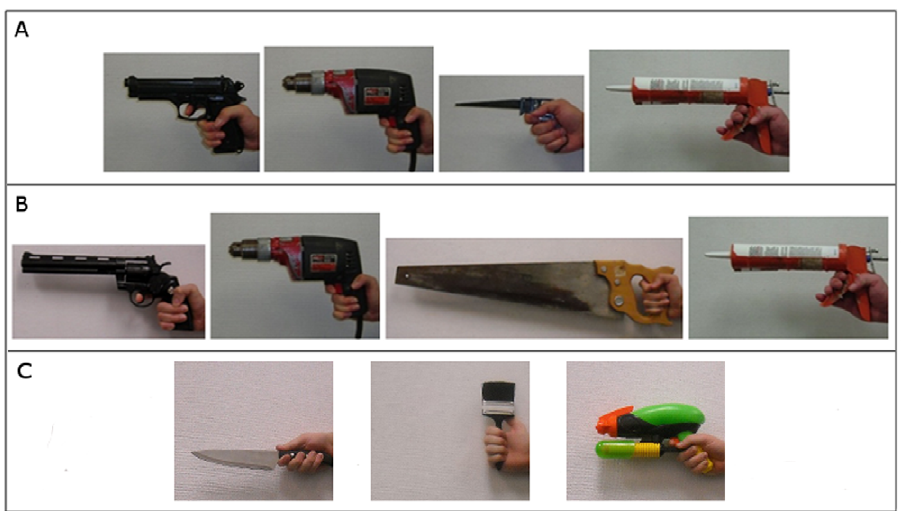
Figure 2. Stimuli. Panel A: In Study 1, participants rated the height and size of men holding a .45 caliber handgun, a drill, a small handsaw, and a caulking gun. Panel B: In Study 3, participants rated the height, size, and muscularity of men holding a .357 caliber handgun, a drill, a large handsaw, and a caulking gun. Panel C: In Study 5, participants rated the height, size, and muscularity of men holding a kitchen knife, a paintbrush, and a toy squirt gun. In Study 2, participants rated the potential lethality of the objects shown in Panels A and B. In Study 4, participants rated the potential lethality of the objects shown in Panel C, as well as identifying the age (adult vs. child) and gender of the persons most associated with using each object. Photographs, presented to participants in color, were resized so that the objective dimensions of each hand displayed on the participant’s